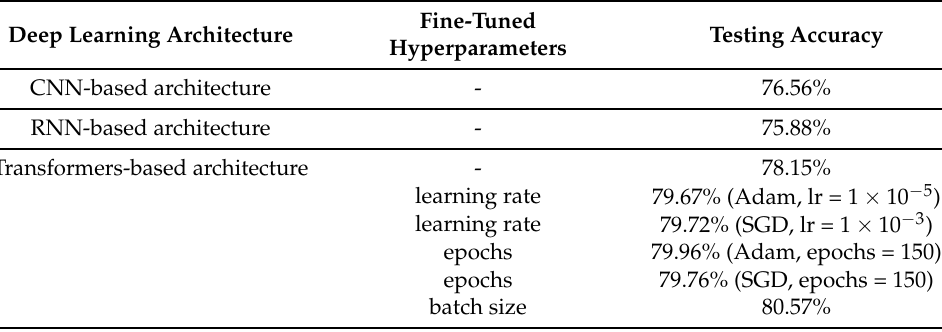
Table 5. Results comparison among the three deep learning